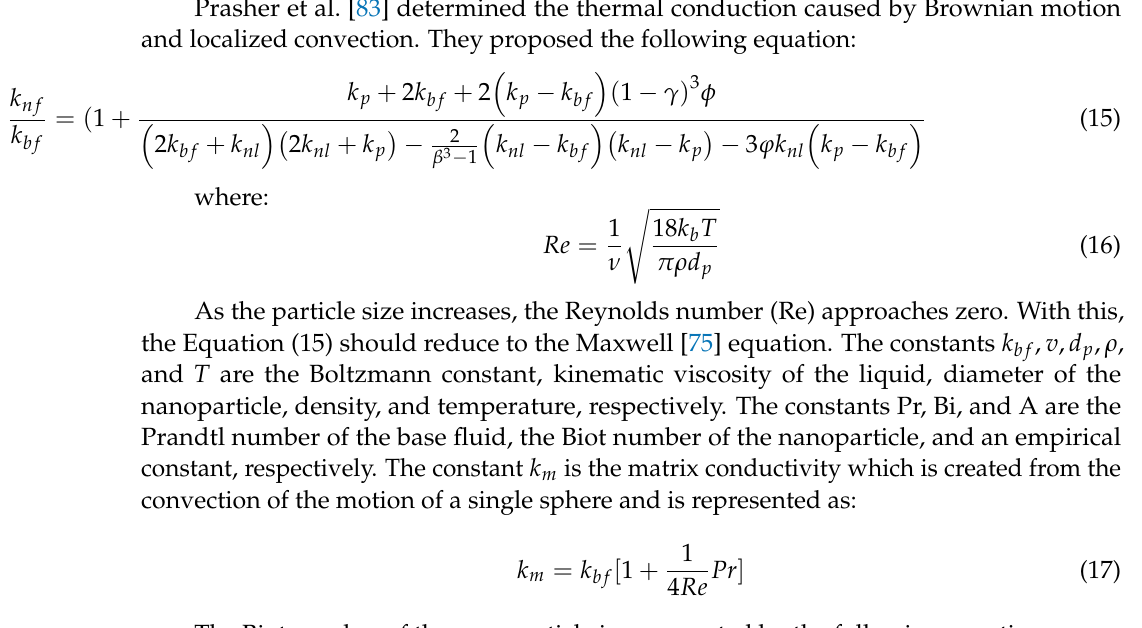
Figure 38. A representation of a singular nanoparticle under random motion caused by Brownian motion.